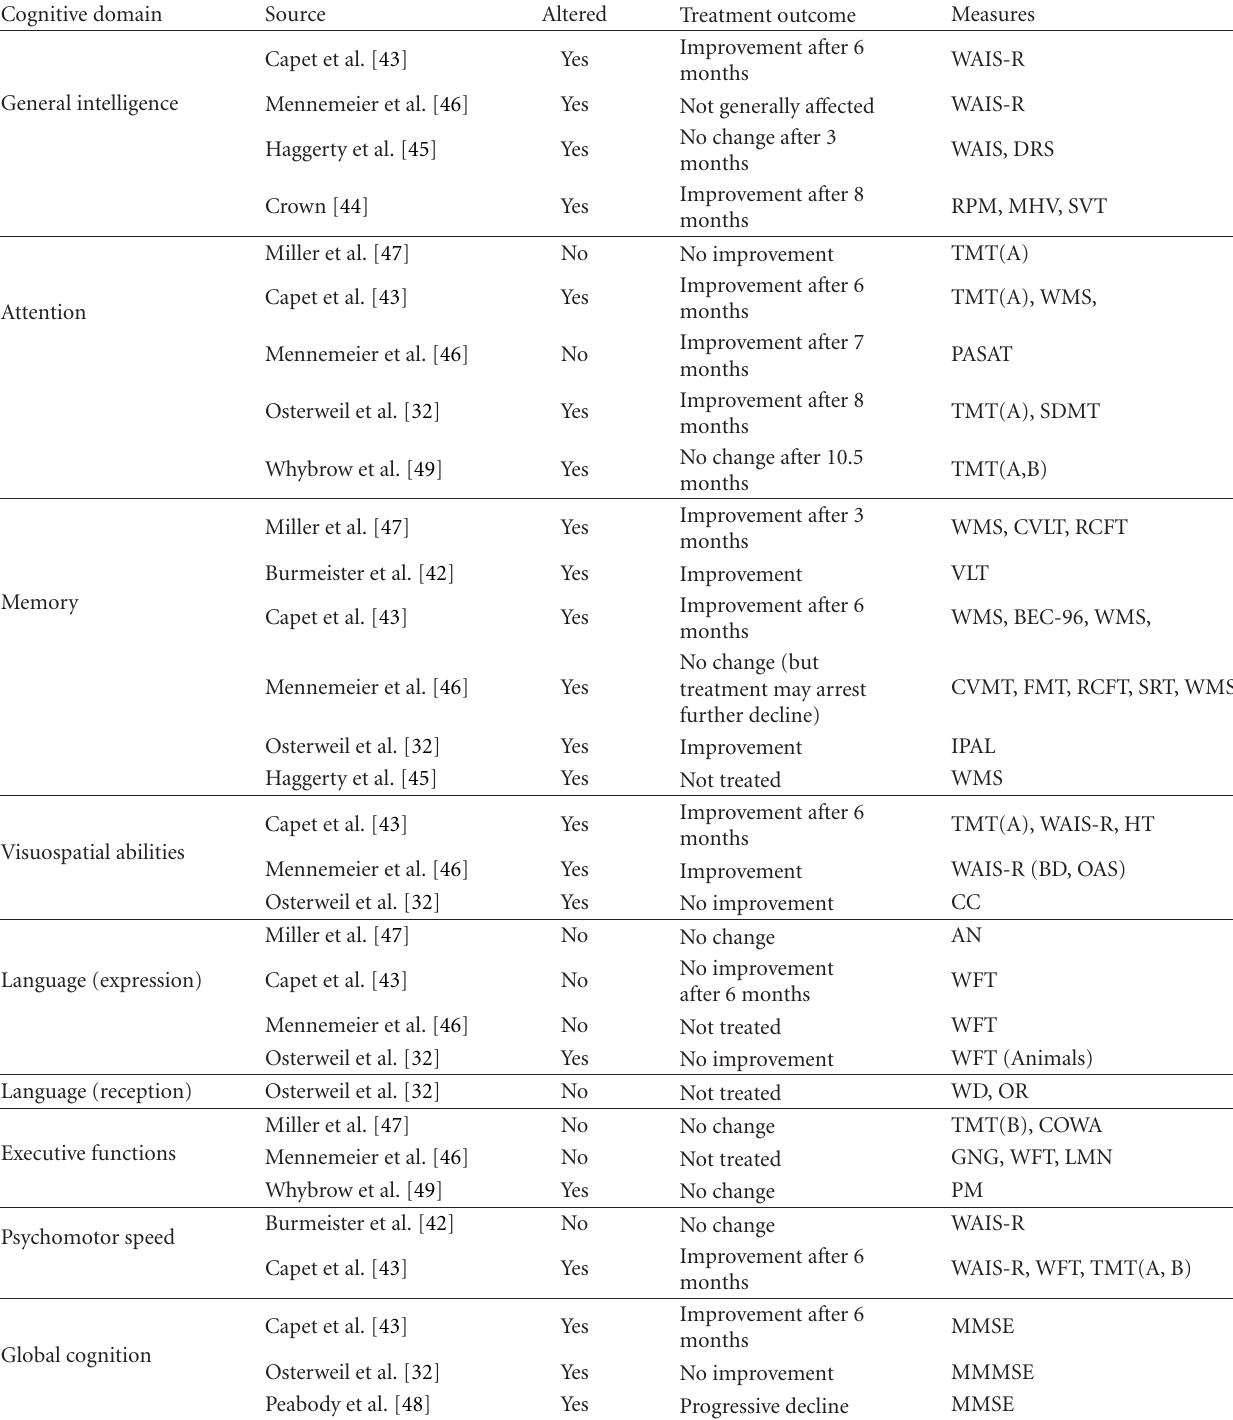
Table 4: Cognitive deficits in adult clinical hypothyroidism (AN: animal naming; BD: block design of WAIS-R; BEC-96: recall and visuoverbal recognition test; CC: cube copy; COWA: controlled oral word association; CVLT: California verbal learning test; CVMT: continuous visual memory test; DRS: Dementia rating scale (Mattis); DS: digit symbol subtest; FMT: Milner facial memory test; GNG,: Go- No go; HT: Hooper test; IPAL: Inglis paired associates learning; LMN: Luria m’s and n’s; MHV: Mill hill vocabulary scale; MMSE: